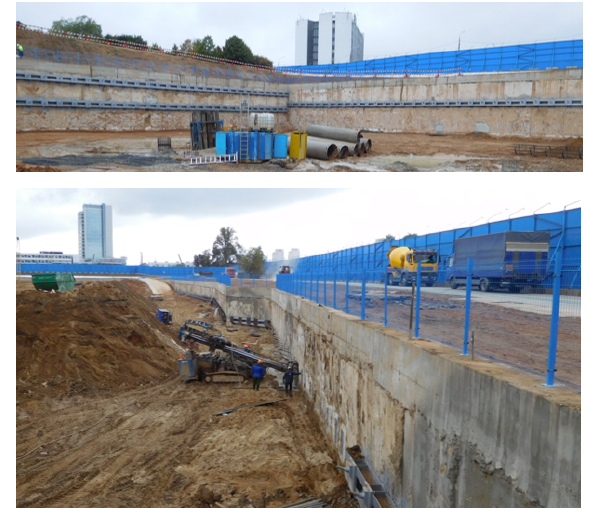
Figure 2. Excavation pit overview and installation of anchoring